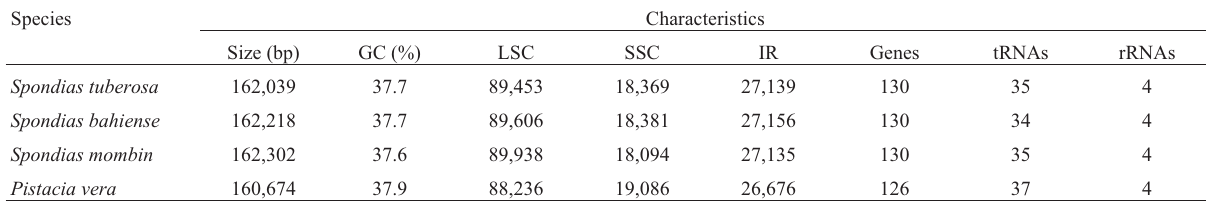
Table 2 - Summary of the chloroplast genome characteristics within the Anacardiaceae family. Genome size (bp), GC content (%), large single copy re- gion - LSC (bp), small single copy region - SSC (bp), inverted repeat - IR (bp), N. of protein-coding genes, N. of tRNAs, and N. of rRNAs.